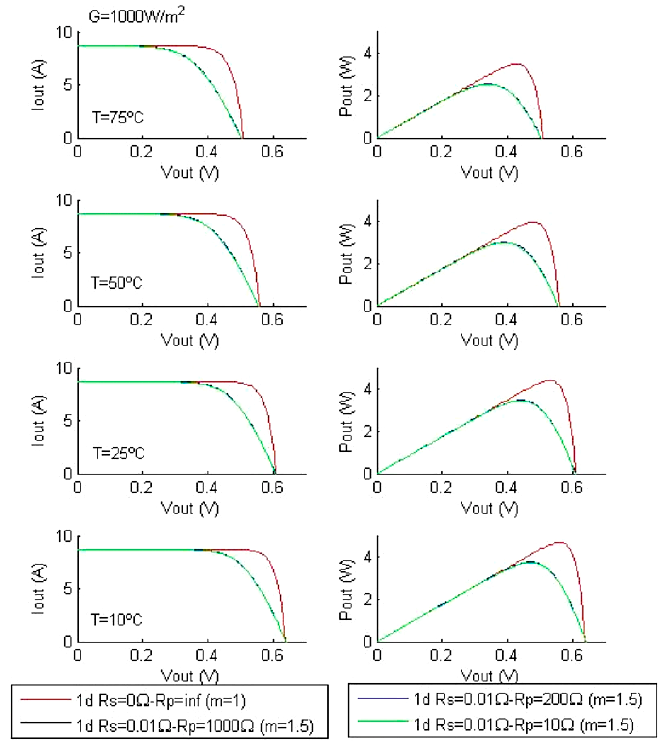
Figure 5. Characteristic curves in function of temperature and parallel resistance R p , with a constant resistance R s (G = 1000 W/m 2 ). Energies 2018 , 11 , x FOR PEER REVIEW